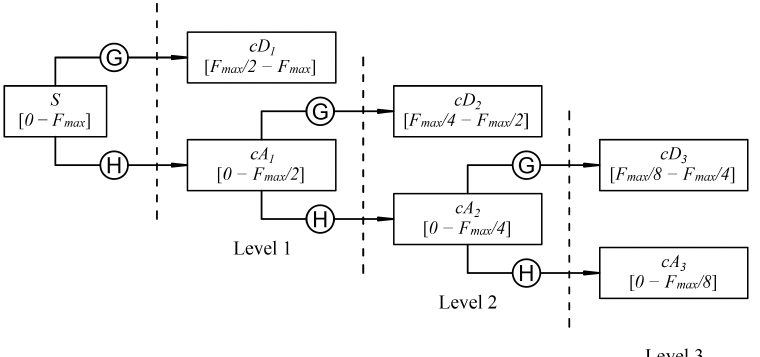
Figure 2. Identification of frequency bands related to the various coefficients as a function of the decomposition level. G indicates the high-pass filter and the following down sampling, while H indicates the low pass filter and the following down